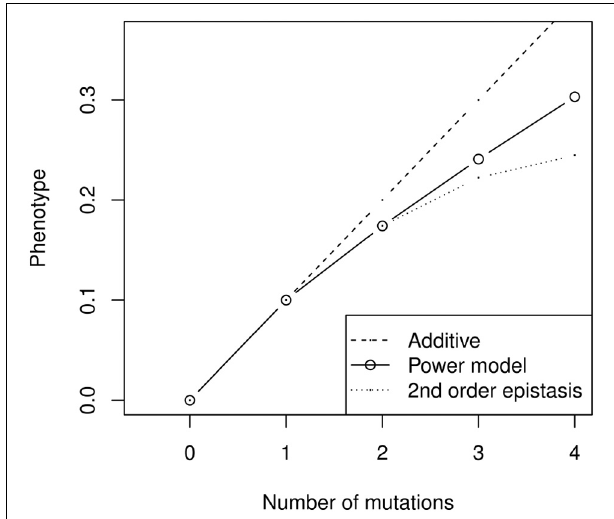
FIGURE 6 | Illustration of high-order epistatic effects in the power model (here with negative epistasis, α n β with α = 0 . 1 and β = 0 . 8). The second-order epistatic effect is negative (the power model is always below the additive prediction), but the third-order effect is positive (the power model is always above the quadratic model). The sign of the interactions thus alternates when β < 2, and their relative size does not decrease rapidly. As a result, the effect of combining several mutants cannot be properly inferred from simpler combinations—for instance, the prediction for four mutants is not much better for the second-order epistatic model than for the additive model, and can even be worse with more